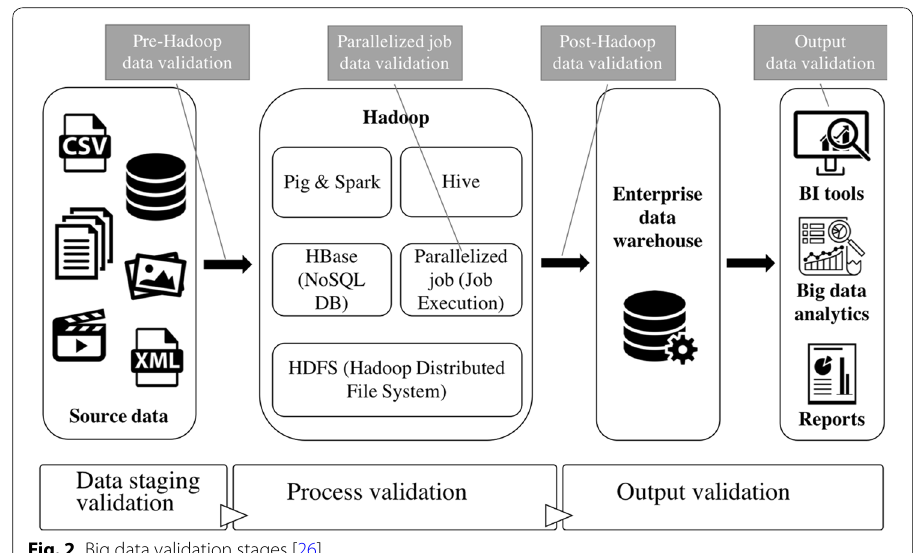
Fig. 2 Big data validation stages